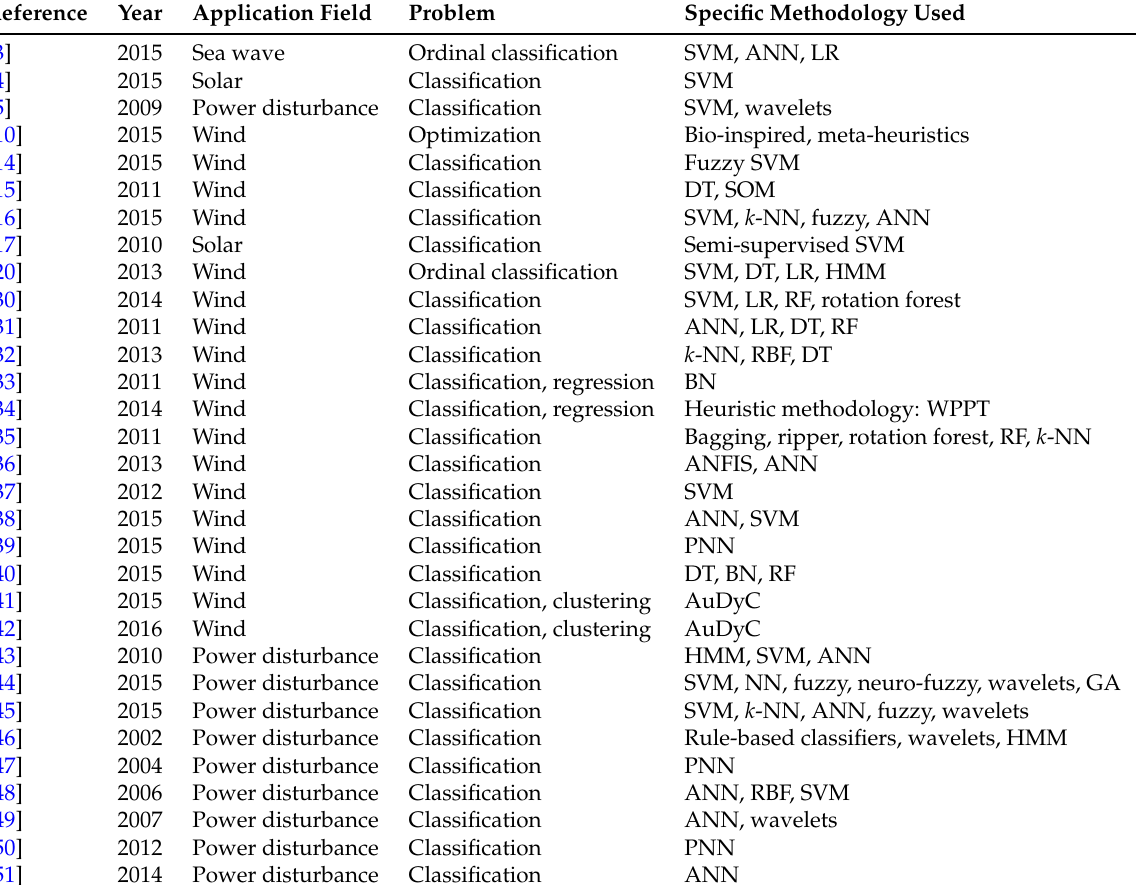
Table 2. Summary of the main references analyzed, grouped by application field, problem type and methodologies considered